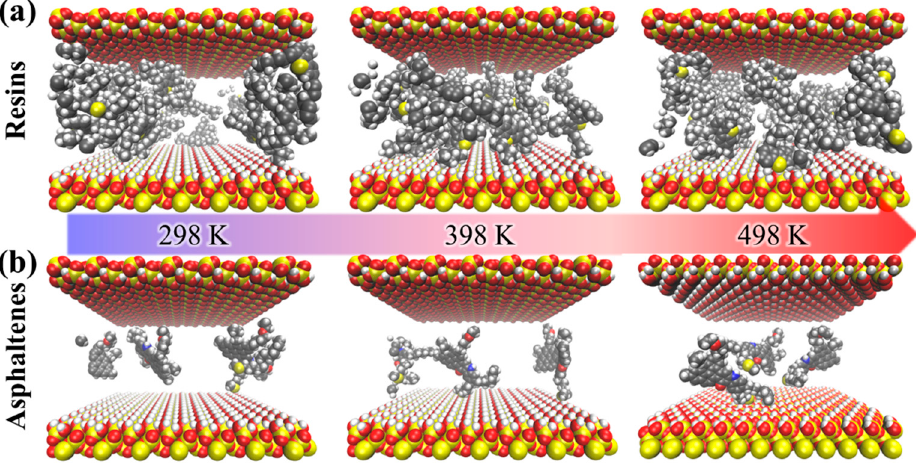
Figure 6. Snapshots of final configurations of ( a ) resins, ( b ) asphaltenes in quartz nanopore at 298 K, 398 K, and 498 K, respectively.